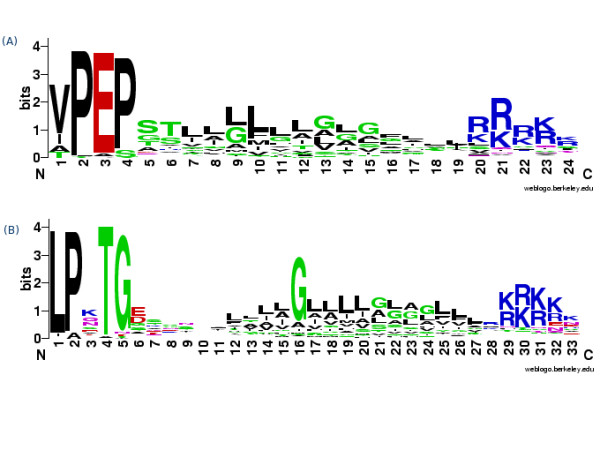
a) Consensus sequence LOGO [27] of the PEP-CTERM motif. PEP-CTERM consists of a highly conserved Proline-Glutamate-Proline triad followed by a hydrophobic putative transmembrane region and finally a positively charged segment. b) Consensus sequence LOGO of the LPXTG motif.